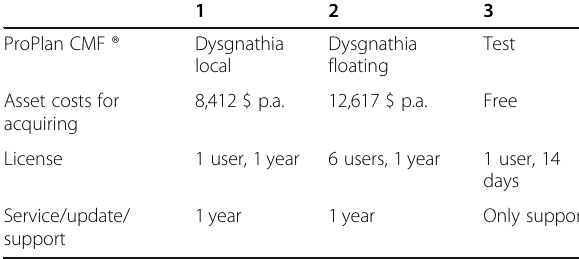
Table 3 Overview of the costs of the VSP system ProPlan CMF